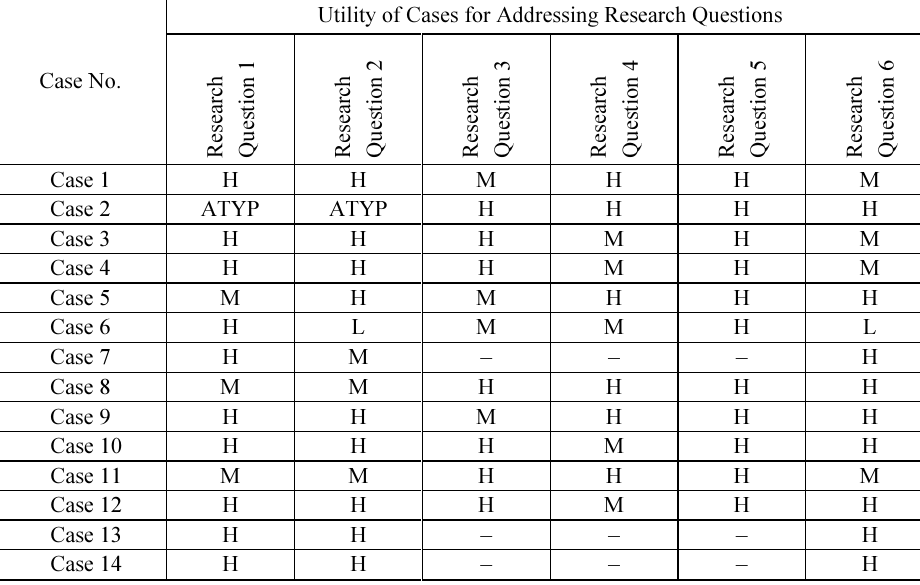
Table 4. Ratings of expected utility of each case for research questions